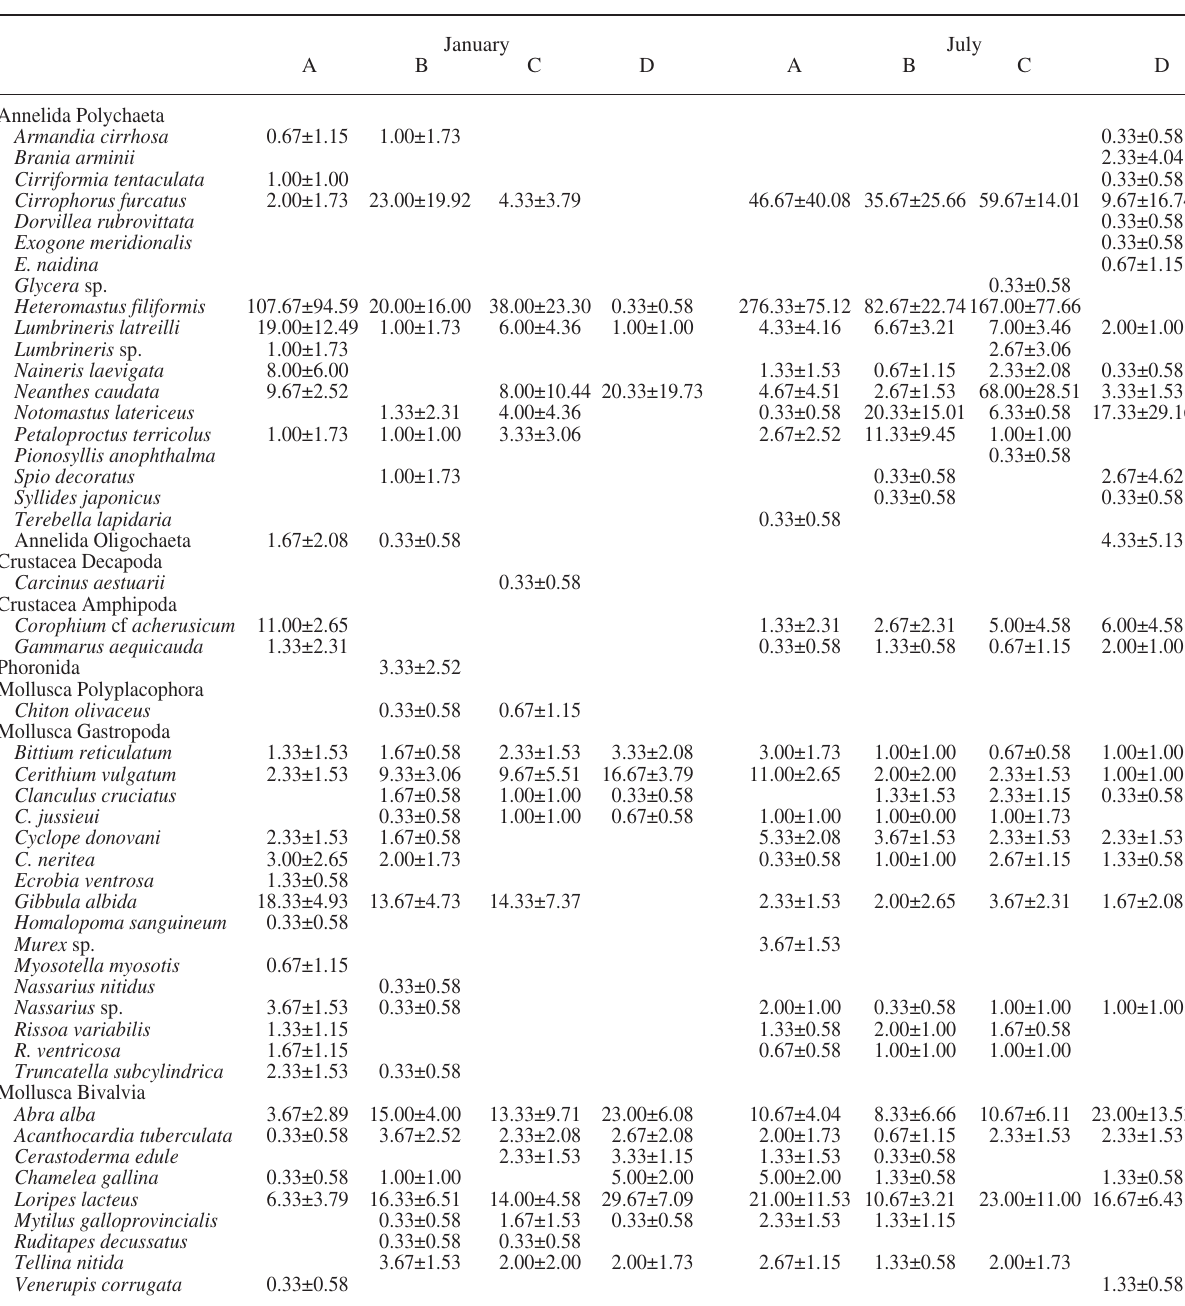
Table 2. – List of the collected taxa. The mean number of individuals per site (± S.D.) in the two sampling times is reported.